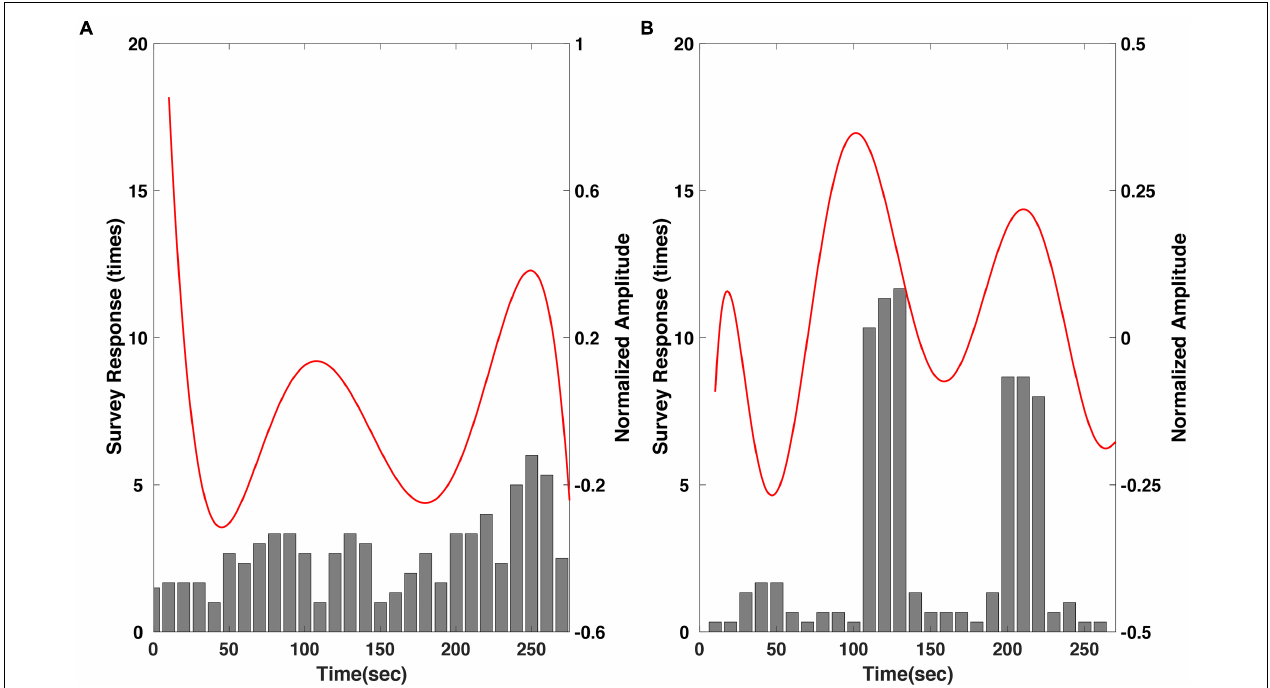
FIGURE 6 | Comparison of the polynomial regression results of SSVEP response to the survey results of the most emotionally arousing scenes in the clips, for the (A) “fear” and (B) “nervous” videos. Please note that the survey results were moving averaged with a window size of three